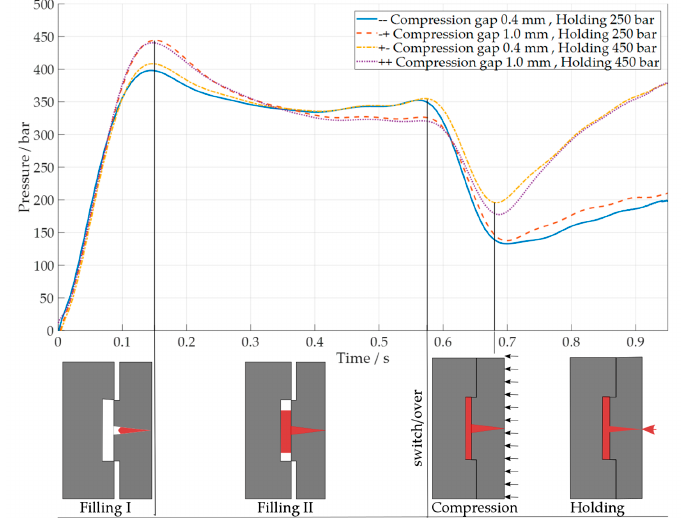
Figure 11. Injection pressure over time for a two-level compression gap (0.4–1.0 mm) and holding pressure (250 bar–450 bar). Compression gap of 1.0 mm and holding pressure of 250 bar; compression gap of 0.4 mm and holding pressure of 450 bar; compression gap of 1.0 mm and holding pressure of 450 bar: before and after switch/over.